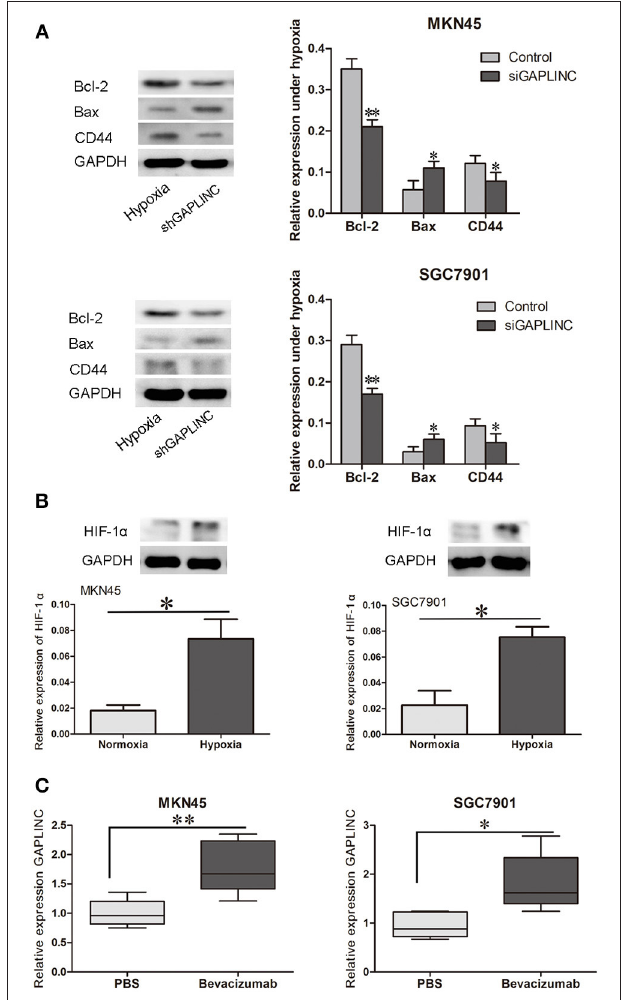
FIGURE 7 | GAPLINC regulated tumor-related proteins under hypoxia and their levels were increased in solid tumors under simulated hypoxic conditions. (A) GAPLINC ablation upregulated Bcl-2, CD44, and TGFBR2 and downregulated Bax in MKN45 and SGC7901 cells under hypoxia (* P < 0.05 vs. the respective control group). (B) Nude mice were treated with the anti-angiogenesis agent bevacizumab or vehicle only. HIF-1 α was induced in tumor xenografts treated with bevacizumab. (C) GAPLINC expression was upregulated in the bevacizumab group compared with the PBS groups (* P < 0.05, ** P <